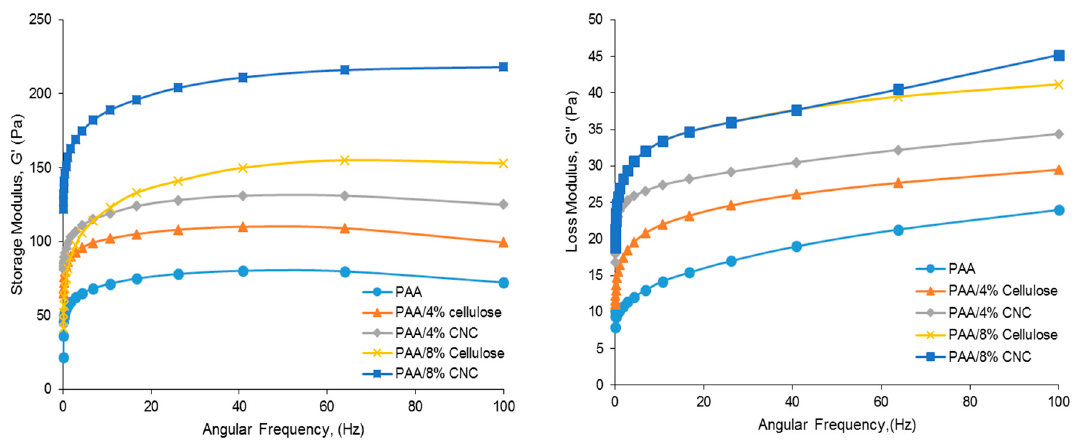
Figure 10. Effect of filler composition on the storage ( left ) and loss ( right ) modulus of PAA hydrogels.